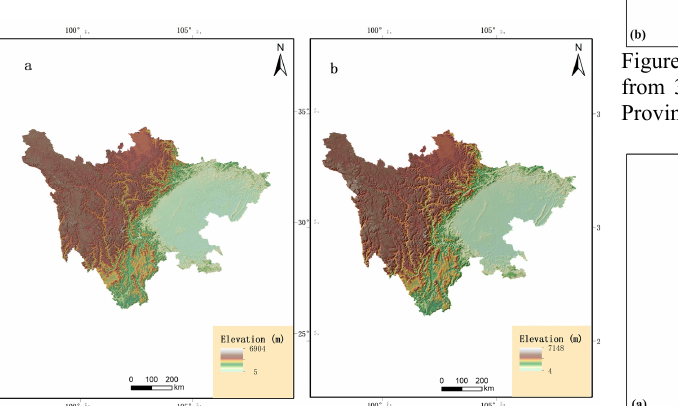
Figure 3. (a) and (b) The topographic map of Shandong province obtained by using 30 arcsec and 3 arcsec DEM data respectively.